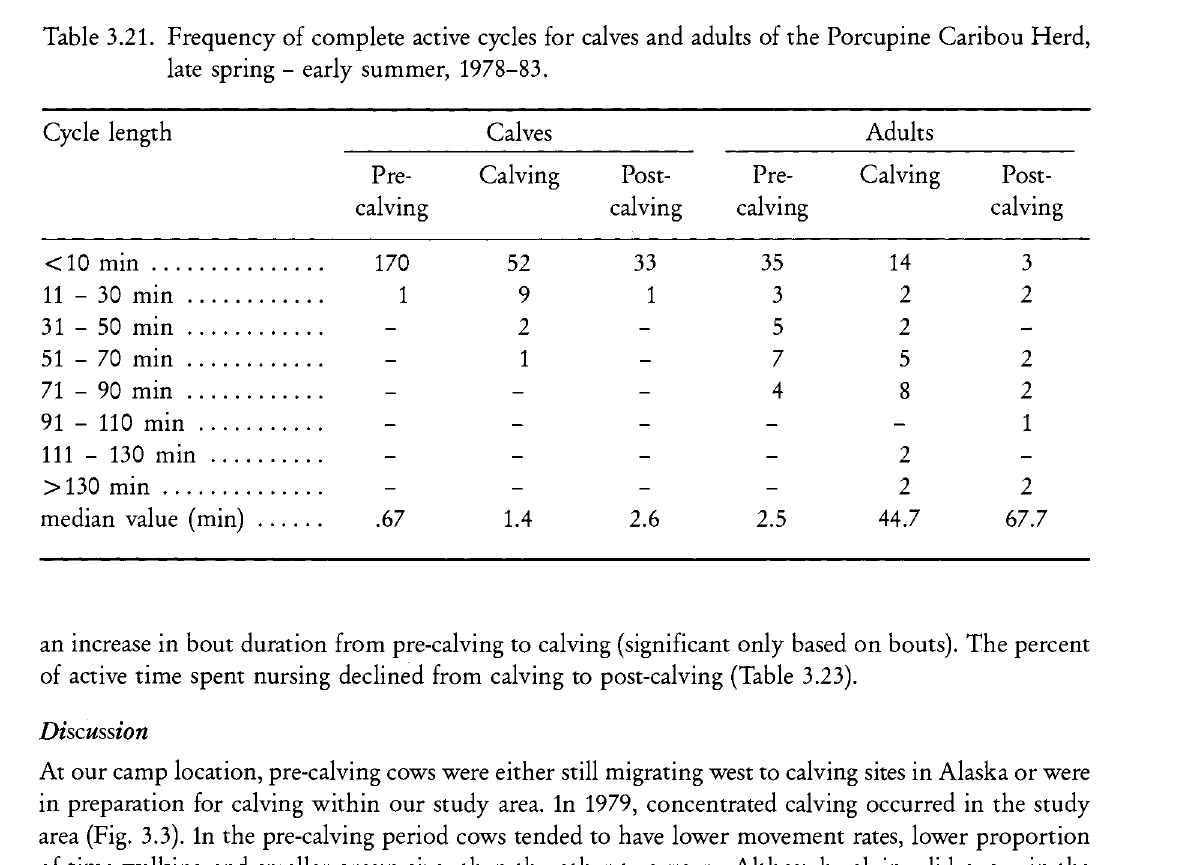
Table 3.22. Frequency of complete bedded cycles for calves and adults of the Porcupine Caribou Herd, late spring - early summer, 1978-83. Cycle